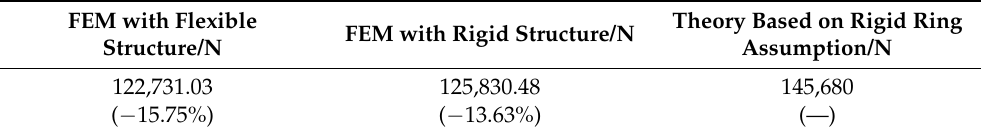
Table 3. Maximum roller load of FEM and theoretical results. FEM with